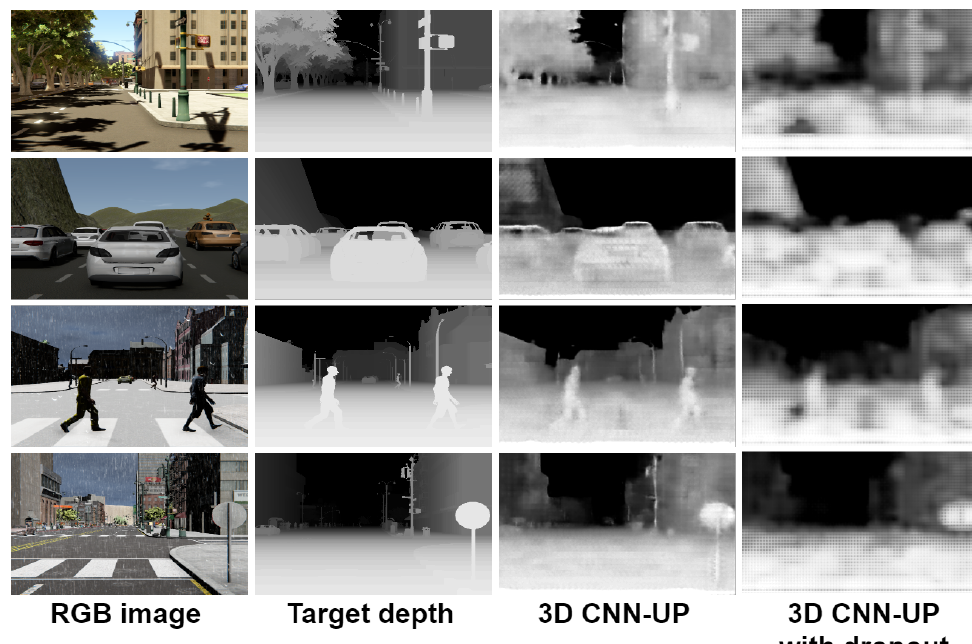
Figure 17. Results obtained with the 3D CNN-UP model (visually enhanced).